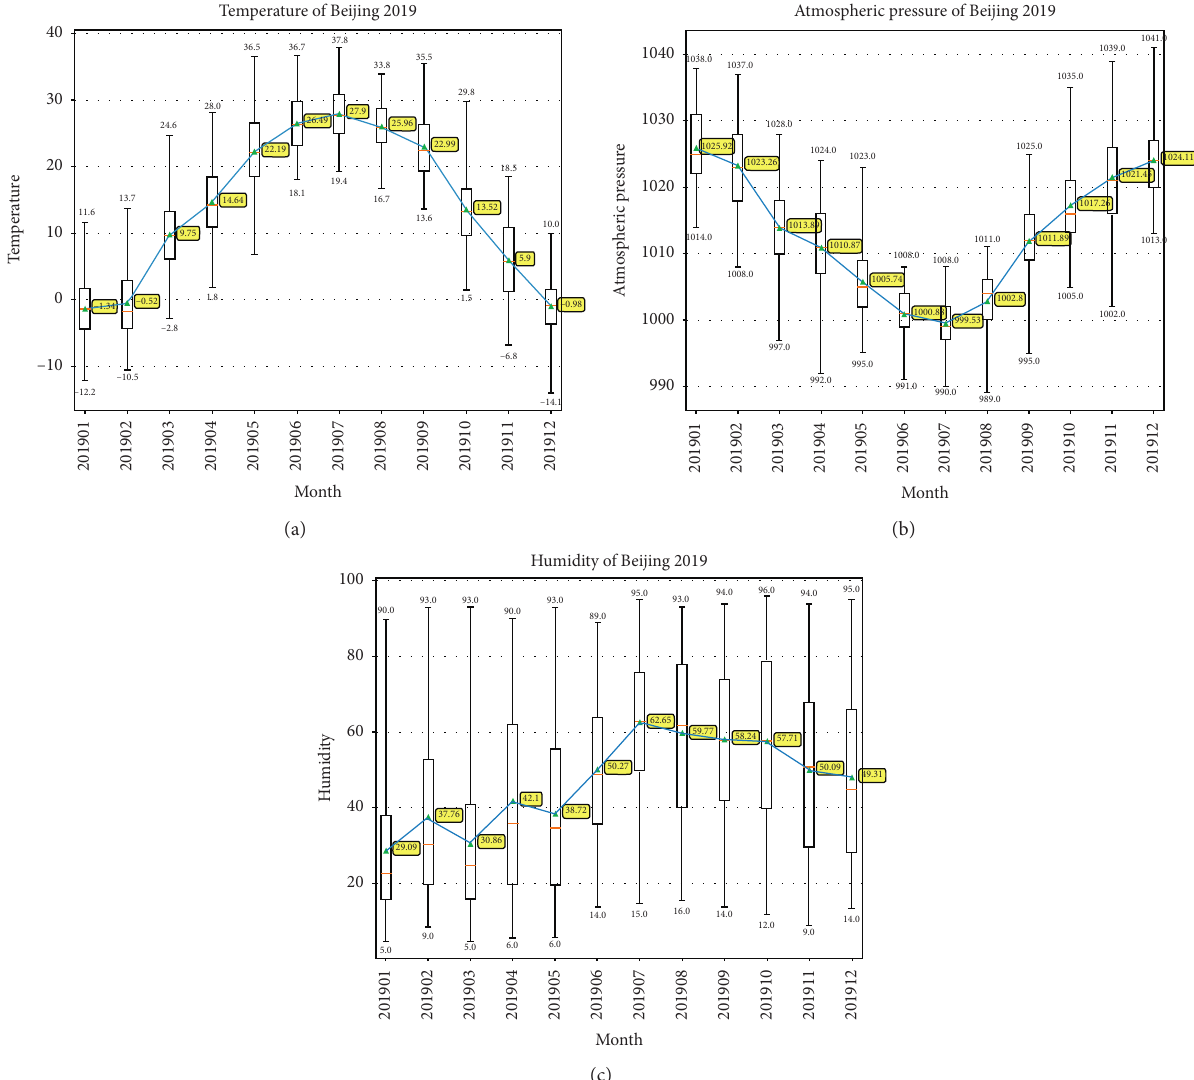
Figure 10: Distribution of air temperature, atmospheric pressure, and relative